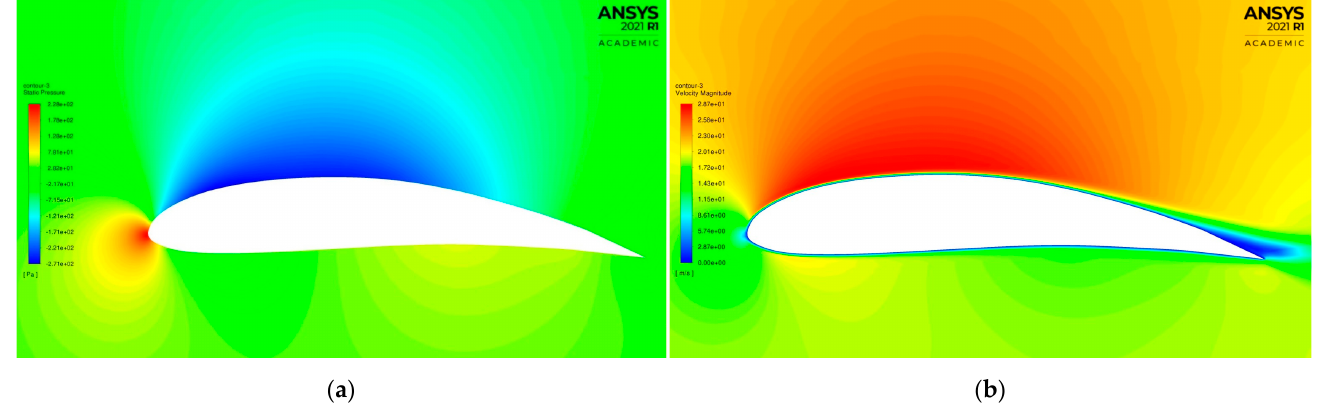
Figure 16. ( a ) Convergence plot of NACA 4415’s / l d c c at various camber angles; ( b ) Local mesh around NACA 4415 (8° camber).